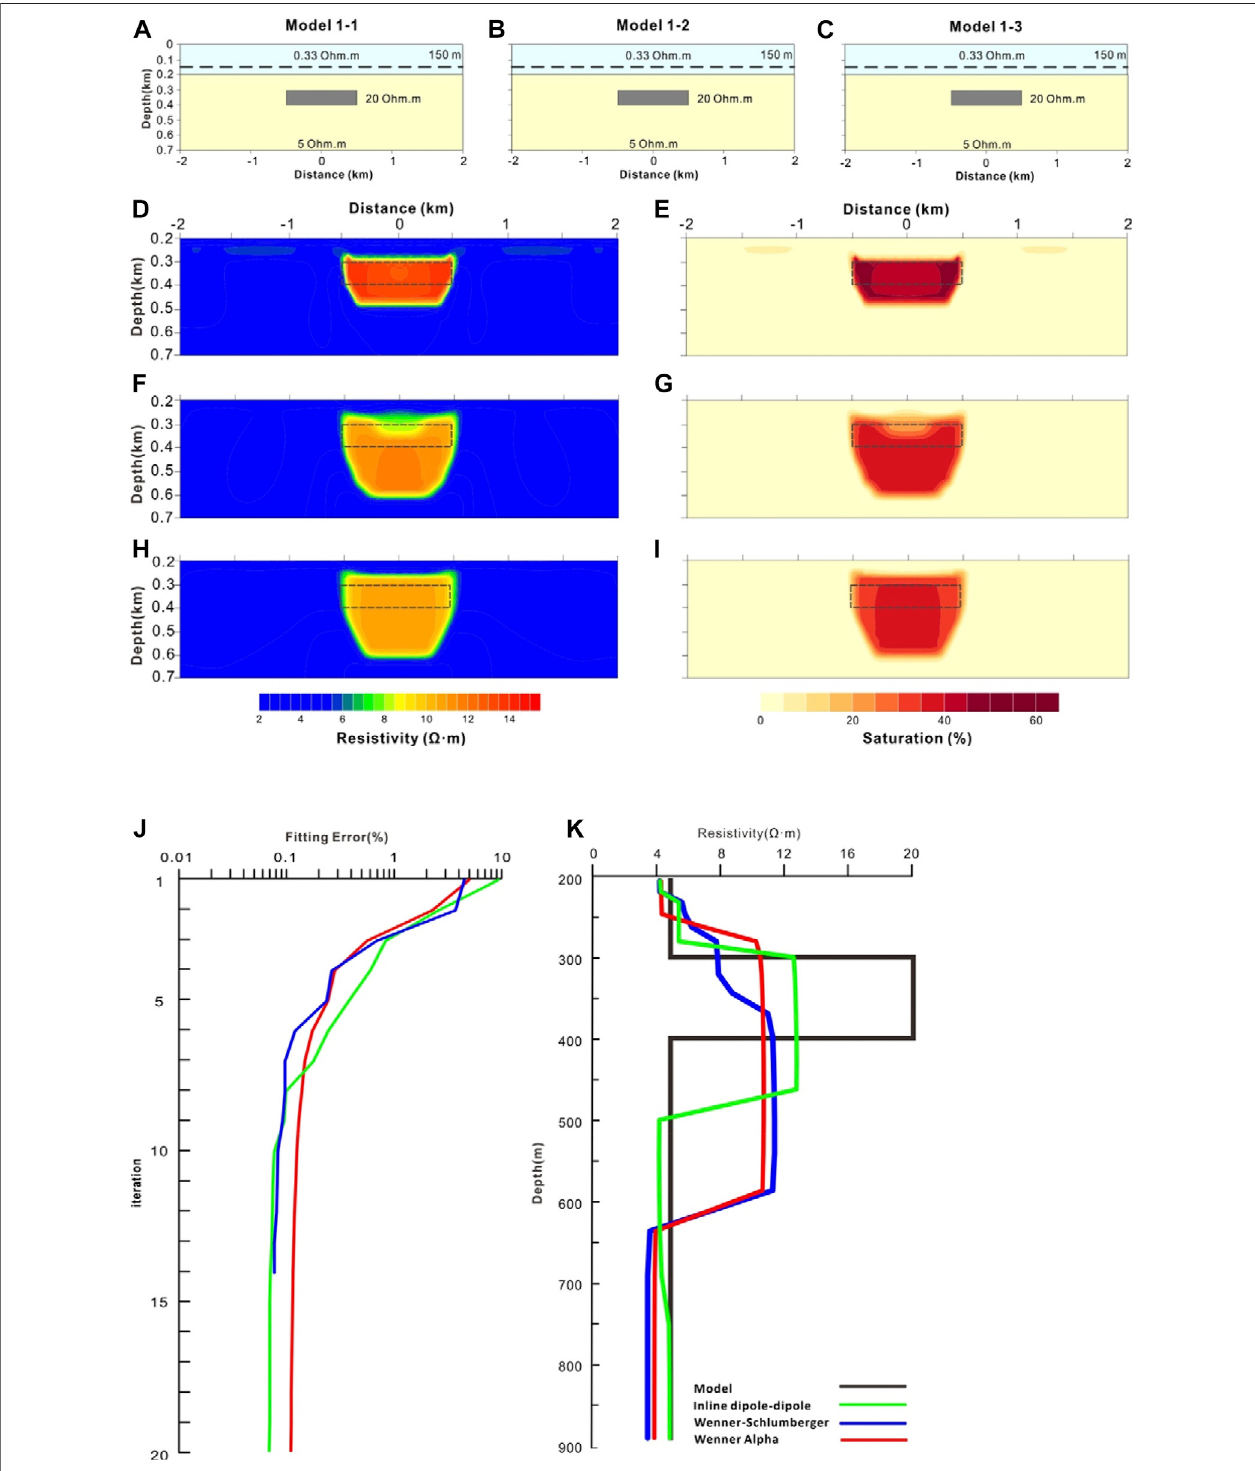
FIGURE 4 | Resistivity inversion and hydrate saturation estimation of variable array model. (A) – (C) : In the schematic diagram of Model 1 – 1, 1-2, and 1- 3 respectively, light blue indicates seawater, light yellow indicates marine sediments, gray block indicates hydrate reservoirs, dotted line indicates the track of the towed resistivity array; (D) , (F) and (H) : the inversion resistivity of Model 1 – 1, 1-2, and 1-3 respectively; (E) , (G) and (I) : the hydrate saturation of Model 1 – 1, 1-2, and 1- 3 respectively (J) : the inversion iteration convergence of Model 1 – 1(green), 1 – 2(blue) and 1 – 3 (red), respectively (K) : the resistivity pro fi le with depth at the center x position of hydrate reservoir of Model 1 – 1(green), 1 – 2(blue) and 1 – 3 (red), respectively.